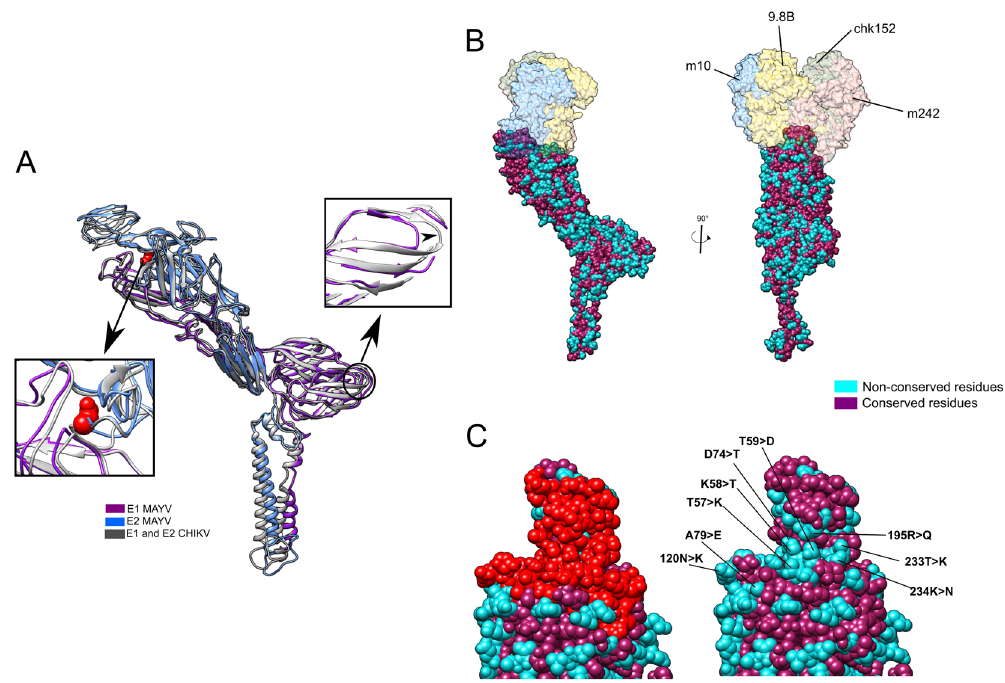
Fig. 3 Comparison of E1 – E2 ectodomains structure and sequence from MAYV and CHIKV. A Structural alignment of E1 and E2 domains from MAYV (blue and purple) and CHIKV (grey). The shorter MAYV loop in the E1 III subdomain is highlighted in the right inset. Details of the loop connecting the E2 A and B subdomains, including the missing asparagine in MAYV, are shown in the left inset. B E1 – E2 dimer coloured by conservation in relation to CHIKV and aligned with CHIKV structure in complex with Fab fragments from CHIKV-neutralizing antibodies CHK-9, CHK-152, m242 and m1040. C The interaction sites for the four antibodies are highlighted in red in the MAYV structure. The conservation map on the antibody interaction surface is highlighted, with non-conserved residues in MAYV labelled in